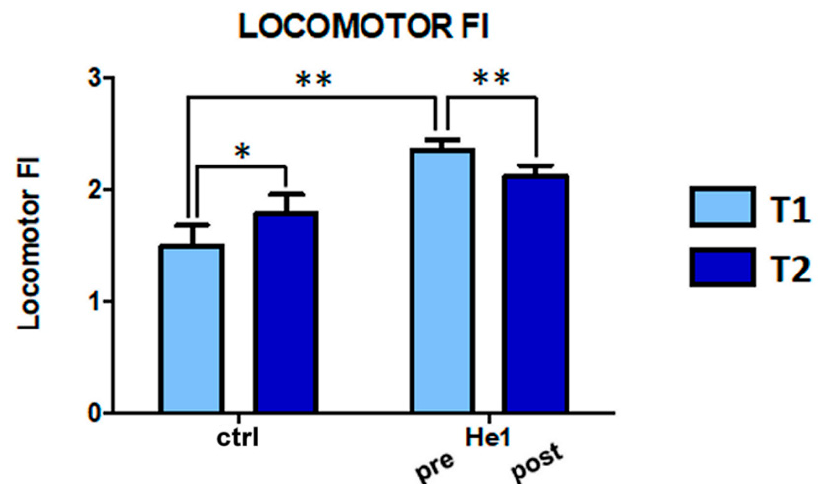
Figure 4. Locomotor frailty index in untreated and He1 treated mice at T1 and T2. Two-way ANOVA was performed for statistical analysis: * p > 0.05; ** p <